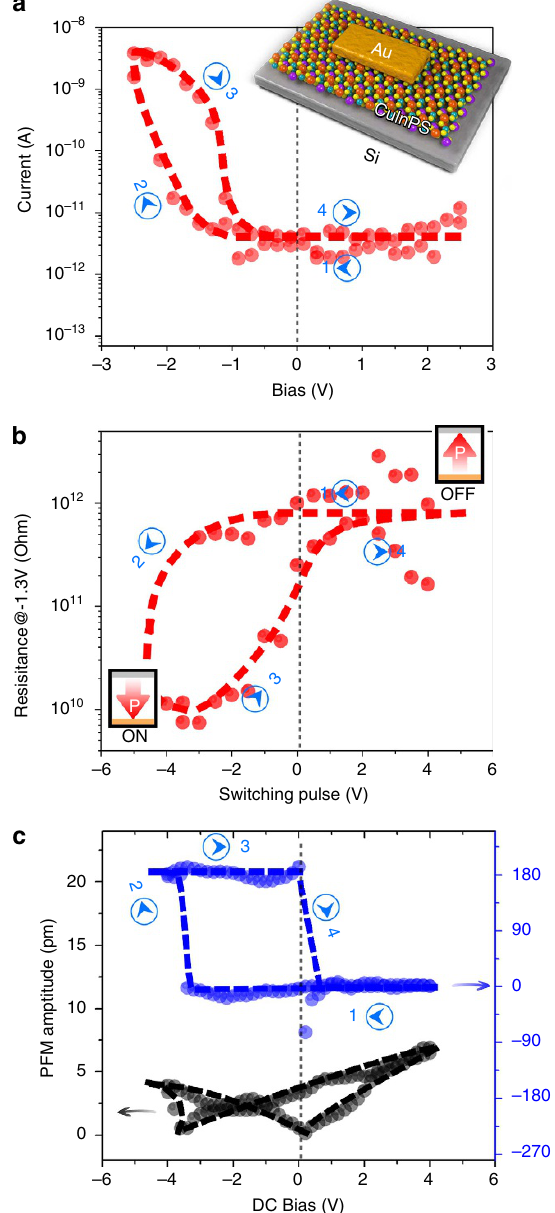
Figure 5 | Electric characterization of the vdW CIPS/Si diode. ( a ) The I – V curves from the typical vdW CIPS/Si diode with 30nm thick CIPS, by sweeping the bias from 2.5 to (cid:2) 2.5V, and then back to 2.5V. Inset is the schematic of the device. ( b ) Resistance-switching voltage hysteresis loop of the diode measured at a bias voltage of (cid:2) 1.3V. The schematic representations of the ON and OFF states with respect to the polarization direction are shown in the bottom-left and top-right insets, respectively. ( c ) Out-of-plane PFM amplitude (black) and phase (blue) measurements on the same diode device shown in a